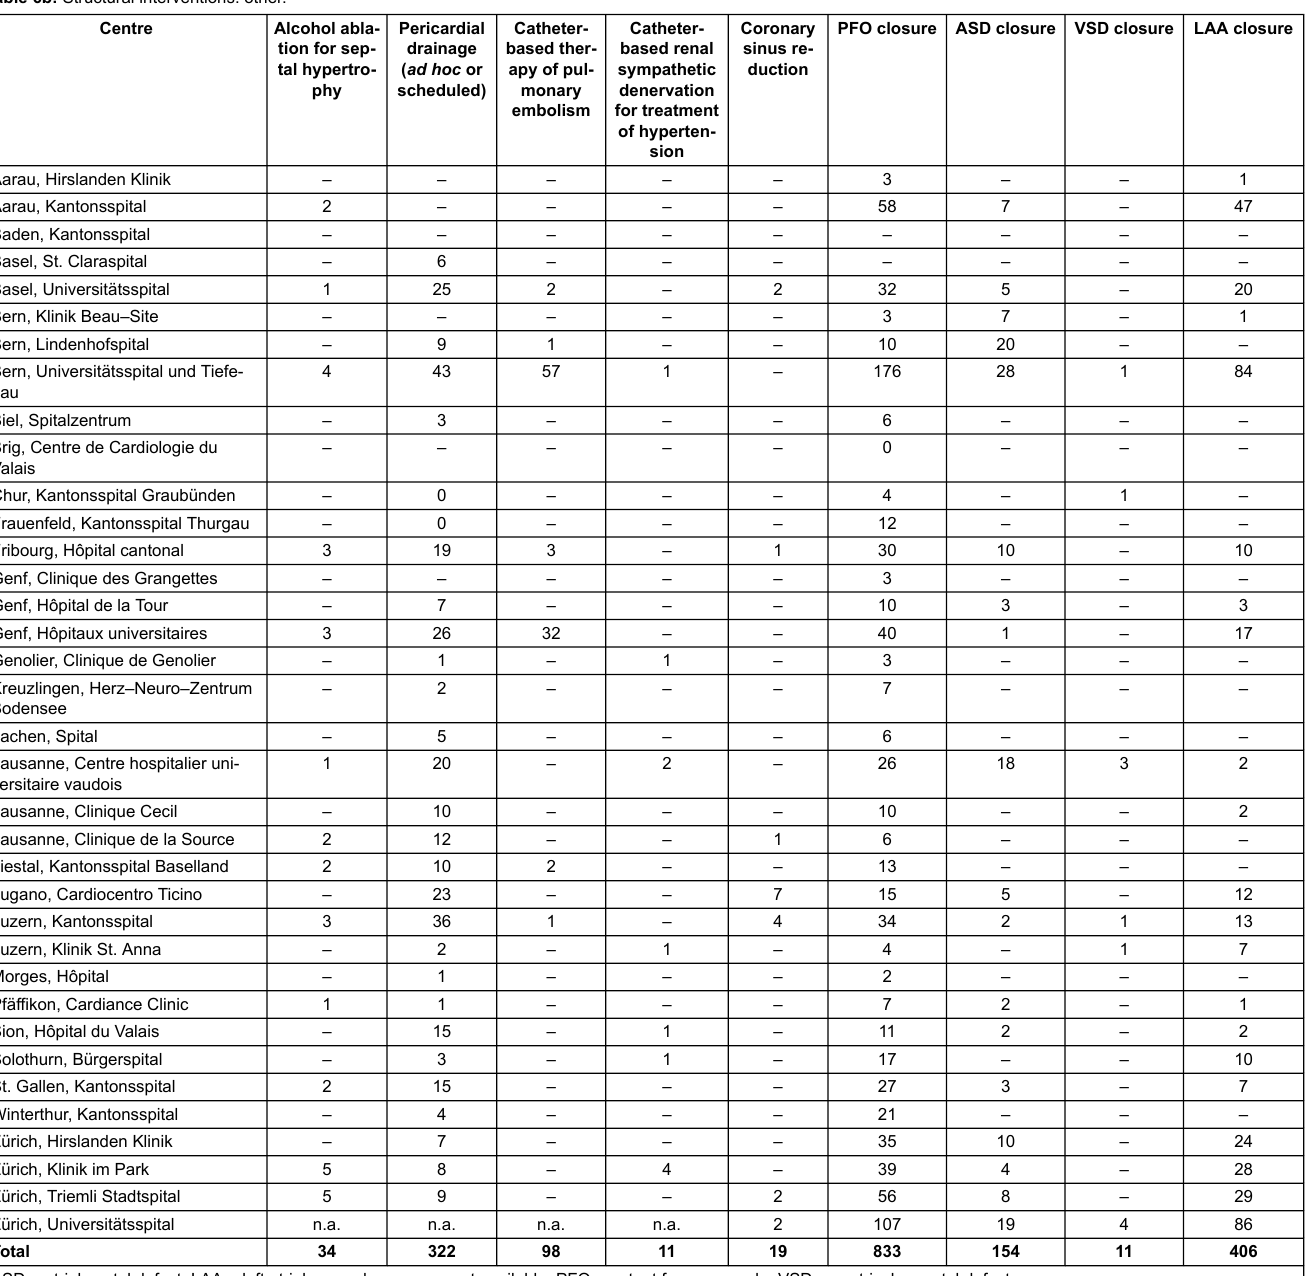
Table 6b: Structural interventions: other. Centre Alcohol abla- tion for